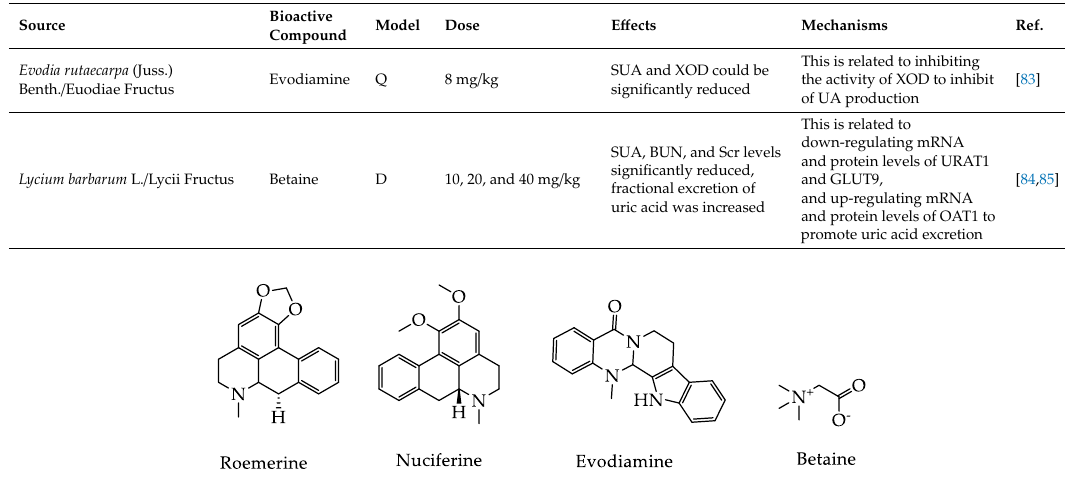
Figure 5. The basic structure of hypouricemic effects from alkaloids bioactive components in plant-based functional foods.